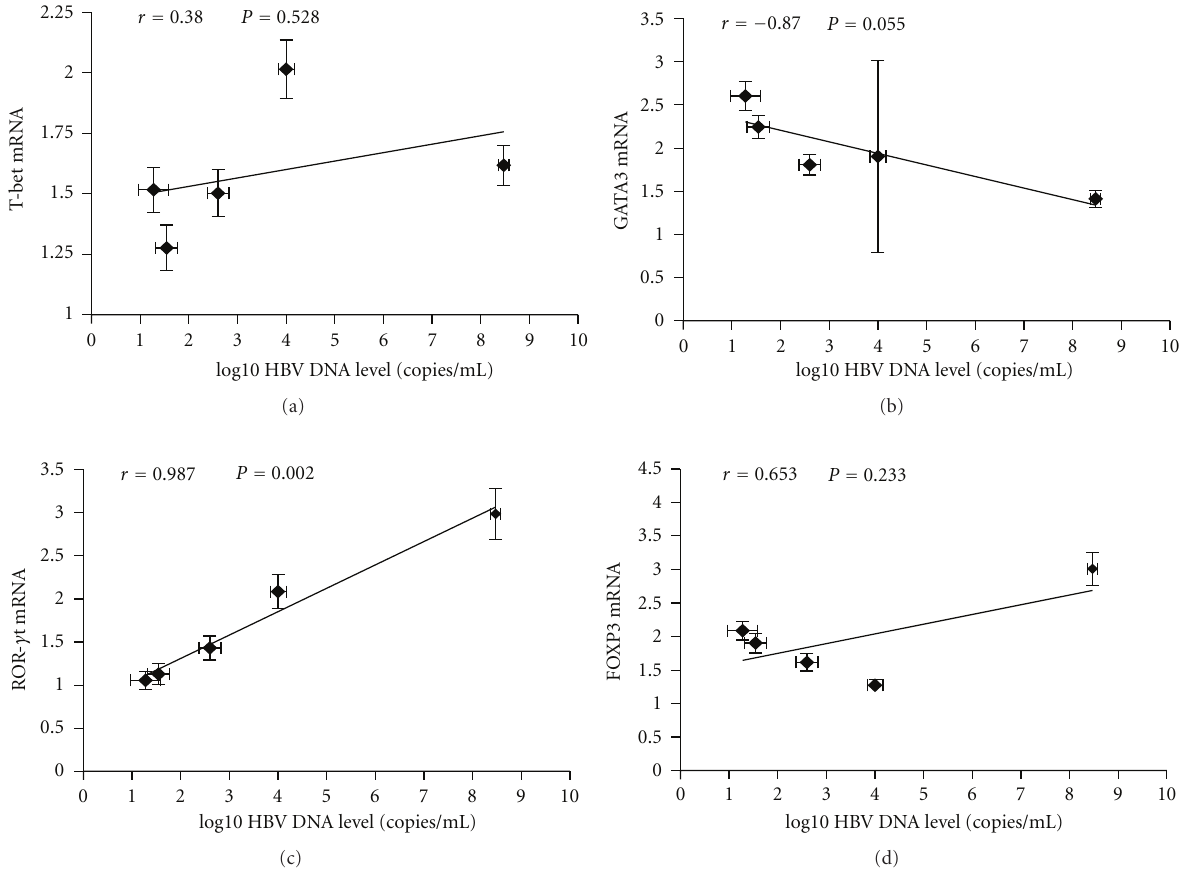
Figure 3: Correlation between the signature transcription factors of CD4 + T-cell subtypes and HBV DNA level. Expressions of the signature transcription factors for each of the CD4 + T-cell subtypes and HBV DNA level at various time points of treatment (baseline and weeks 12, 24, 36, and 52) are indicated on the plots by diamonds. Error bars indicate